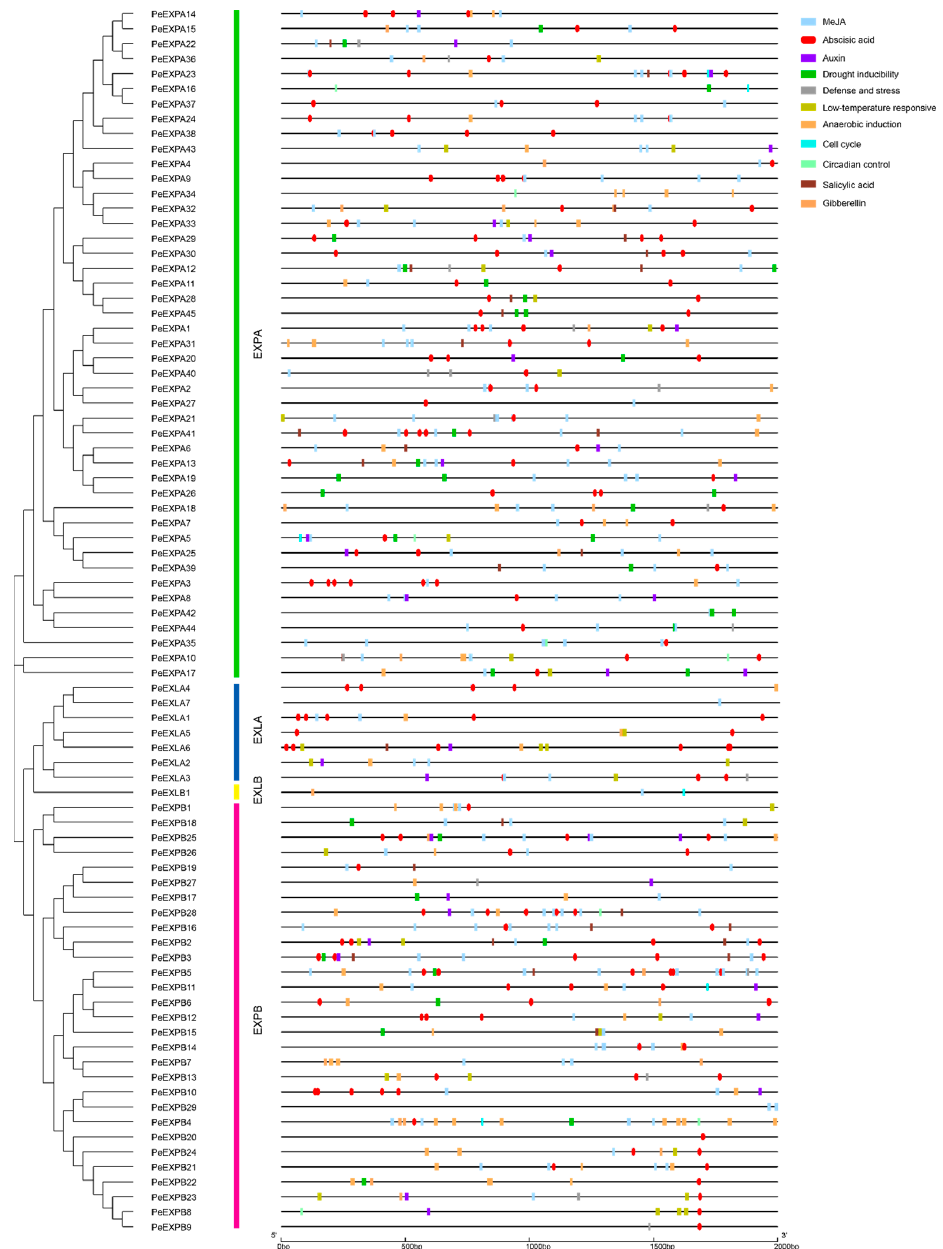
Figure 4. Predicted cis ‐ elements of expansin gene promoters in moso bamboo. Promoter regions 2000 bp upstream of 82 PeEXs analyzed by PlantCARE. Different ‐ colored rectangles represented different cis ‐ elements, and ABA response elements are highlighted in red ellipses.